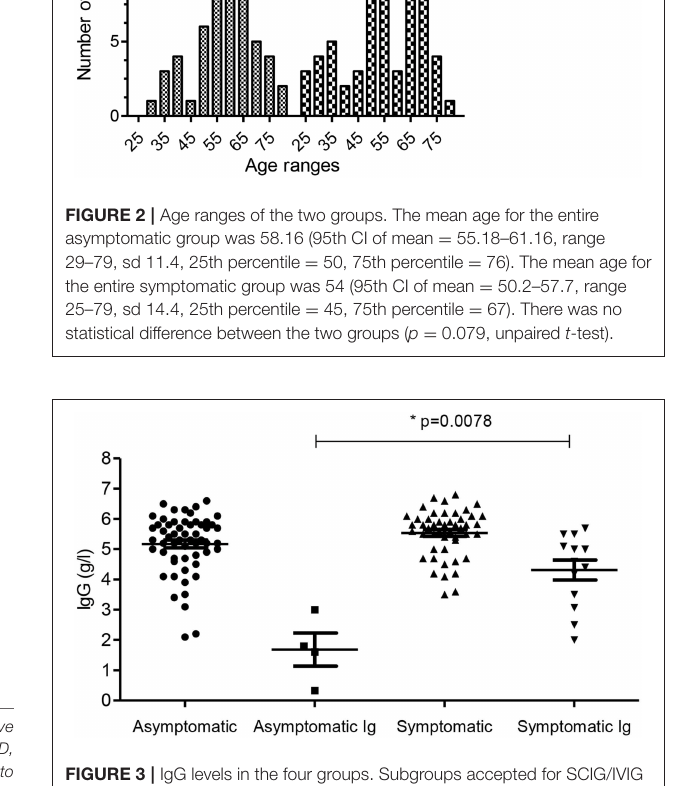
( Figure 4 ), a significant difference ( p = 0.022, Chi square